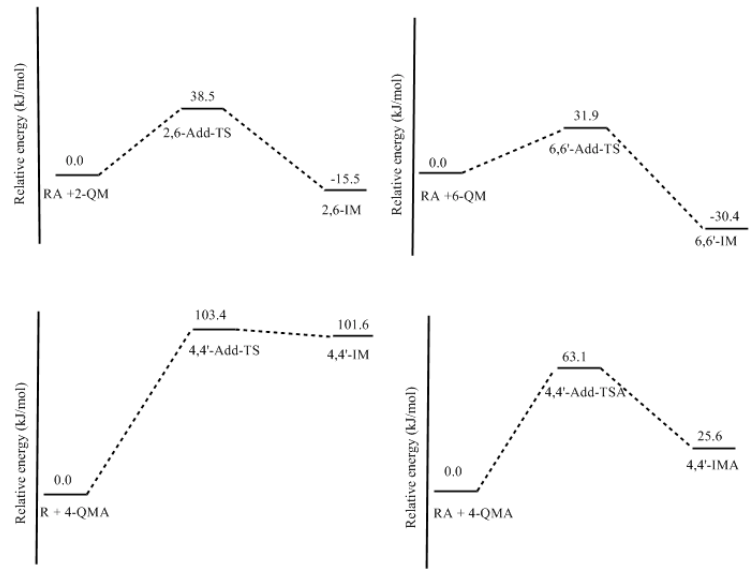
Figure 12. The potential energy profiles for the Michael addition reactions in Figure 10.